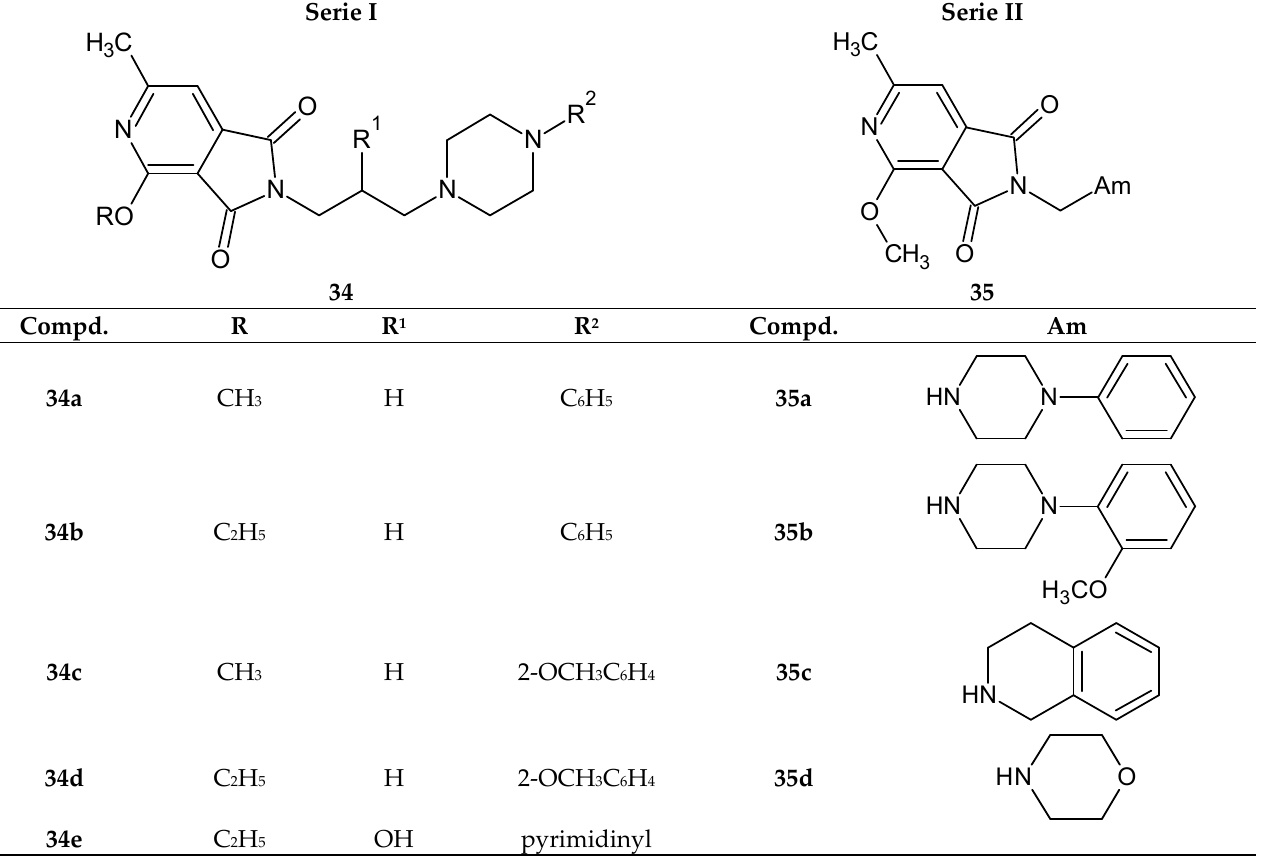
Figure 28. Derivatives of 1 H ‐ pyrrolo[3,4 ‐ c ]pyridine ‐ 1,3(2 H ) ‐ diones 34 and 35 . The analgesic activity of compounds 34 and 35 was tested in two assays: hot ‐ plate and writhing tests. In the writhing syndrome test, all tested substances, i.e., 34 and 35 , showed strong analgesic activity. The strongest effect was produced by compounds 34a and 34c , which were effective up to a dose of 0.78 mg/kg. The most active compound in this test was imide 34c , containing an o ‐ methoxyphenyl substituent at the N ‐ 4 position of piperazine and a methoxy group at position 2 of the pyridine ring. None of the structures obtained was more active than the leading structure 30a in this test. This indicates that the most preferable modification involves removing a hydroxyl group at the β propyl position and introducing of a methoxy group at the ortho position of the phenyl ring. Only compound 35a (the most toxic imide) was more active in the hot ‐ plate test than compound 30a . Compound 35a showed significant activity up to a dose of 9 mg/kg in this test. In the case of 4 ‐ ethoxy derivatives, no increase in analgesic activities was observed concerning imide 30b . The pharmacological results obtained indicate that most of the structures studied show very interesting analgesic properties. The results of preliminary radioligand binding studies suggest that these compounds show a weak affinity for μ‐ opioid receptors, which probably play a role in their mechanism of action. However, the authors do not explain the mechanism of action of the obtained pyrrolo[3,4 ‐ c ]pyridine derivatives [35]. In 2006, the researchers obtained another series of compounds. This time, modifi- cations to model structure 30a involved introducing chlorine and fluorine atoms to the phenyl ring at the N-4 position of piperazine. Additionally, in several cases, the OH group was removed from the linker [36]. The analgesic activity of the compounds obtained in this study was measured using the writhing syndrome and hot-plate tests. All tested imides showed significant antinociceptive activity in phenylbenzoquinone-induced writhing test, and the ED 50 values ranged from 3.51 to 16.04 mg/kg